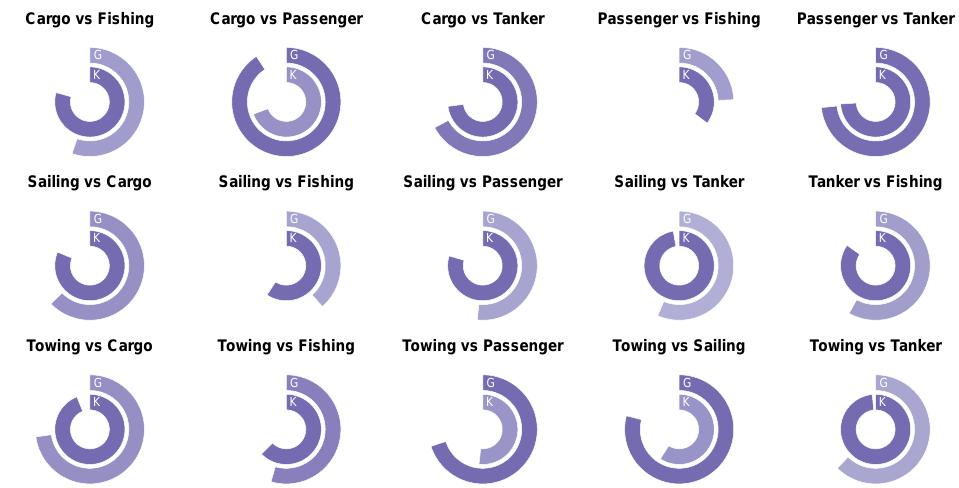
Figure 4. The relative performances of the geometric and kinematic descriptor-based models with reference to the corresponding benchmark models for binary problems. The outer ring depicts the performance of the geometric descriptor-based models and the inner ring depicts the kinematic descriptor-based